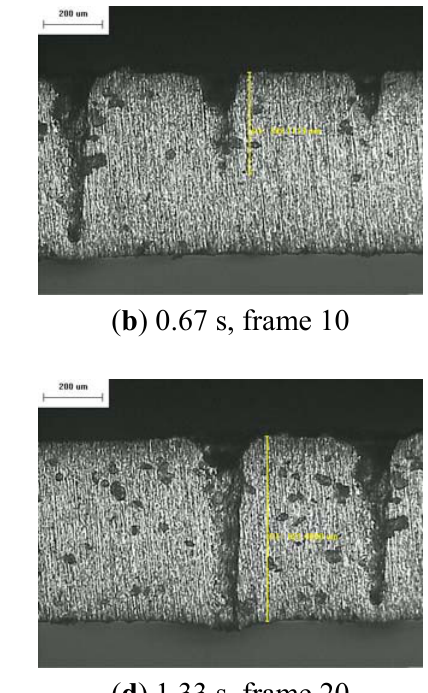
Figure 7. Workpiece (Al 5052) profile images at different process times (radiation energy is 200 mJ): ( a – d ) 50×.